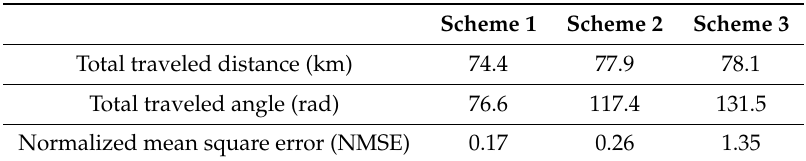
Figure 5. Trajectories of four AUVs obtained by three schemes. The squares indicate the positions of four access points and the initial deployment locations of four AUVs. The circles indicate the acoustic communication coverage of four access points. ( a ) Scheme 1; ( b ) Scheme 2; ( c ) Scheme 3. Table 1. Performance comparison of the three